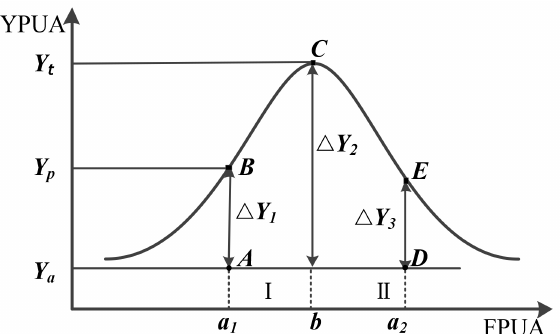
Figure 3. Schematic diagram of the relationship between fertilizer and yield. Note: YPUA is the grain yield per unit area; FPUA is the fertilizer per unit area; Y t is the maximum grain production potential; Y p is the predicted yield; Y a is the actual yield; ∆ Y 1 , ∆ Y 2 , and ∆ Y 3 are the yield gaps; a 1 and a 2 are the actual fertilization